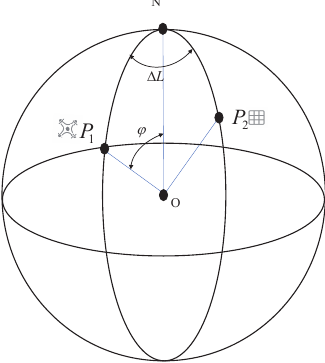
Figure 1. Schematic diagram of the PBVS